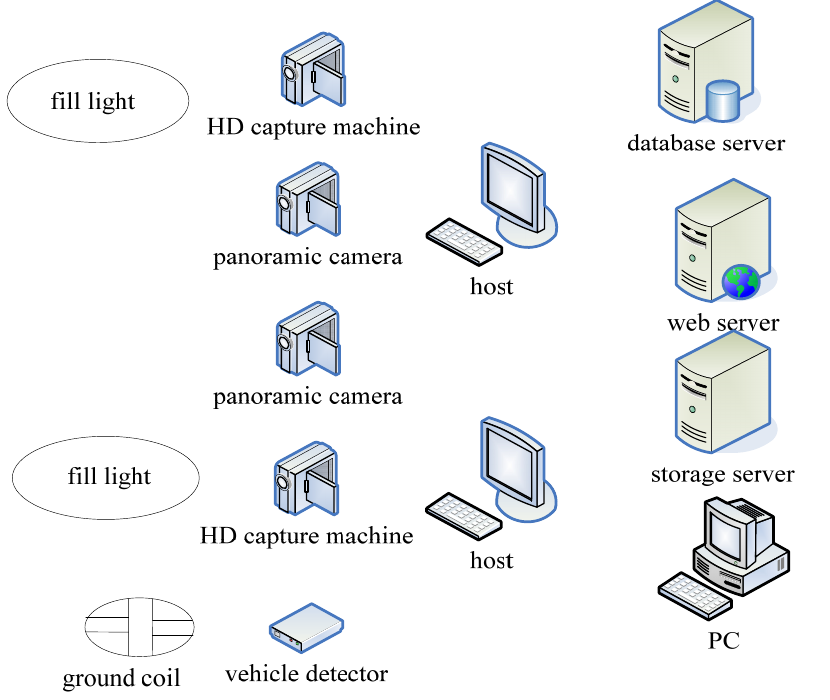
Figure 1. Traffic checkpoint network topology.